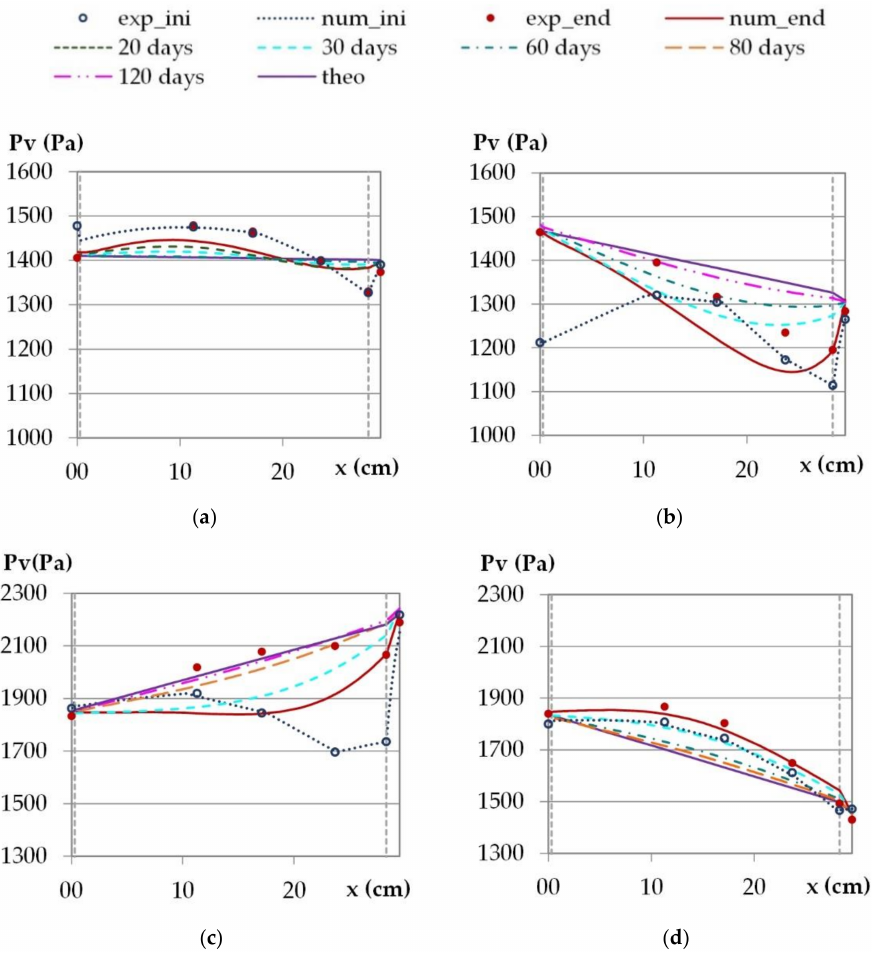
Figure 9. Temperature profiles under constant temperature and vapor pressure gradients, theoretical, experimental and numerical average values over the last 24 h of the stabilization phase: ( a ) climate of Kairouan and ( b ) climate of Djerba (right).